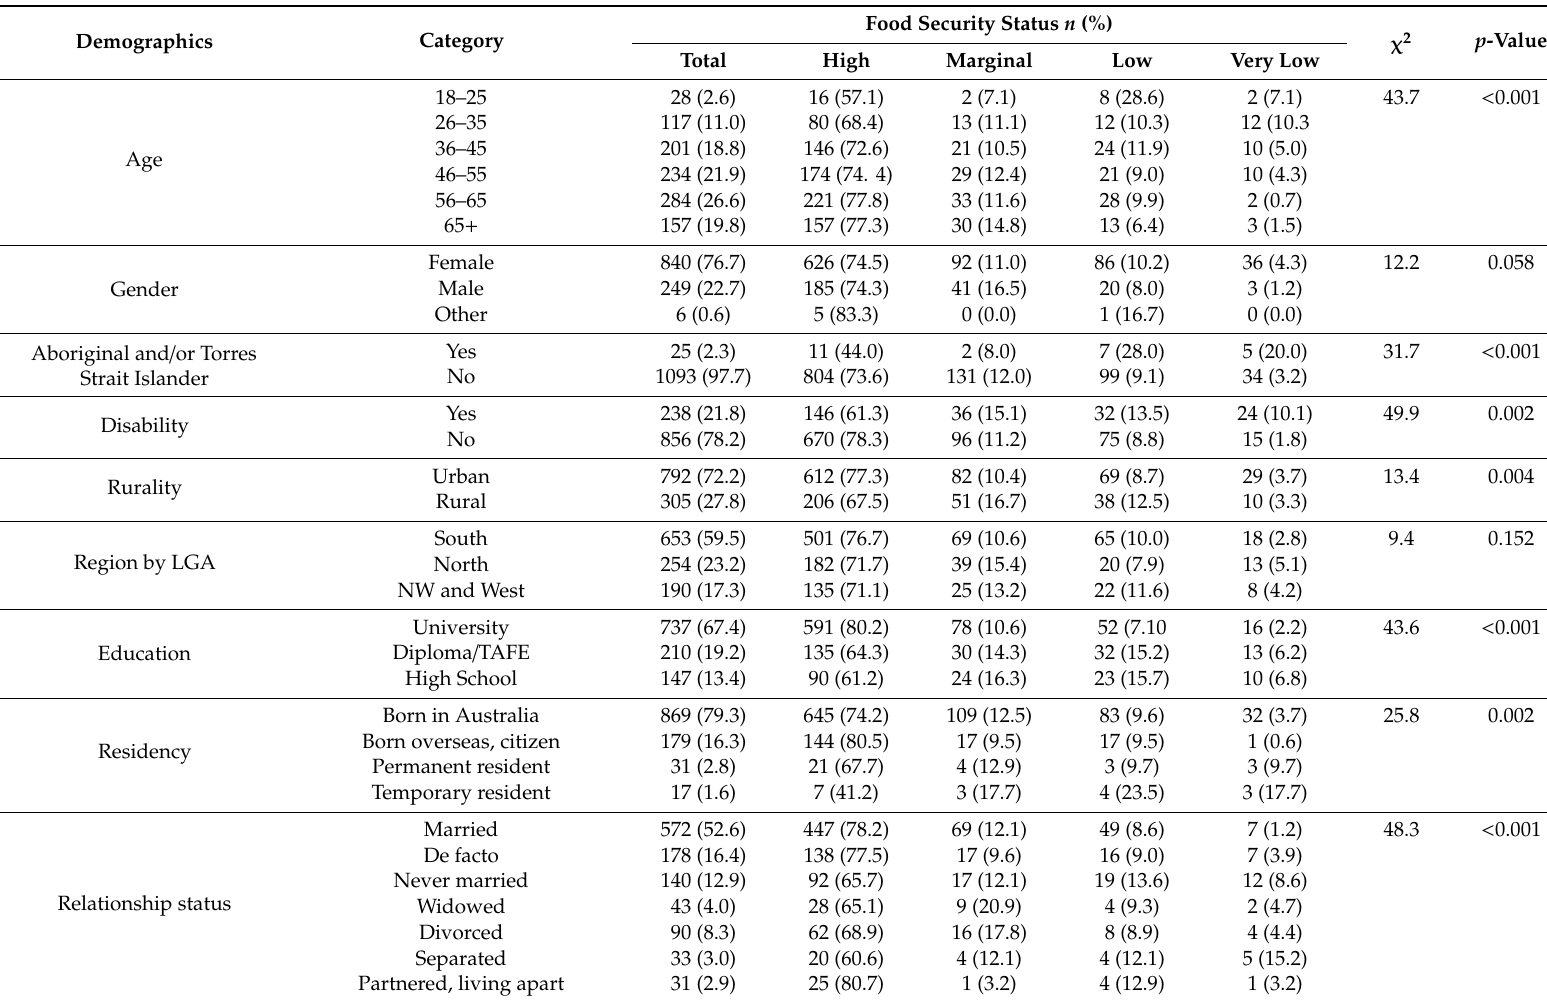
Table 1. Food security proportions by socio-demographic characteristics and impact of COVID-19 on income using Chi-square comparisons.